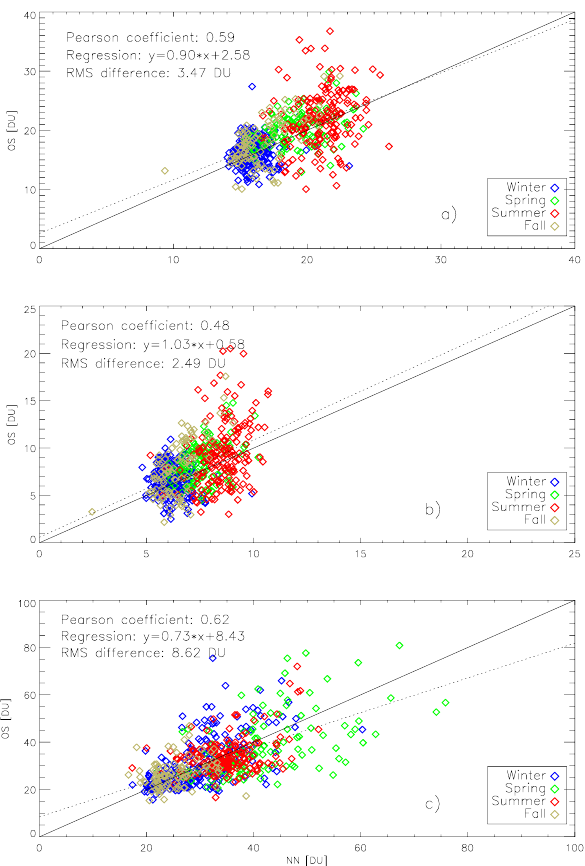
Fig. 11. Scatter plot of test NN retrievals versus corresponding OS values of the ozone columns in the altitude intervals: (a) sur- face to 506.625hPa, (b) surface to 759.937hPa, and (c) 759.937 to 200.0hPa, for the test data set. Seasons are plotted in different col- ors (see